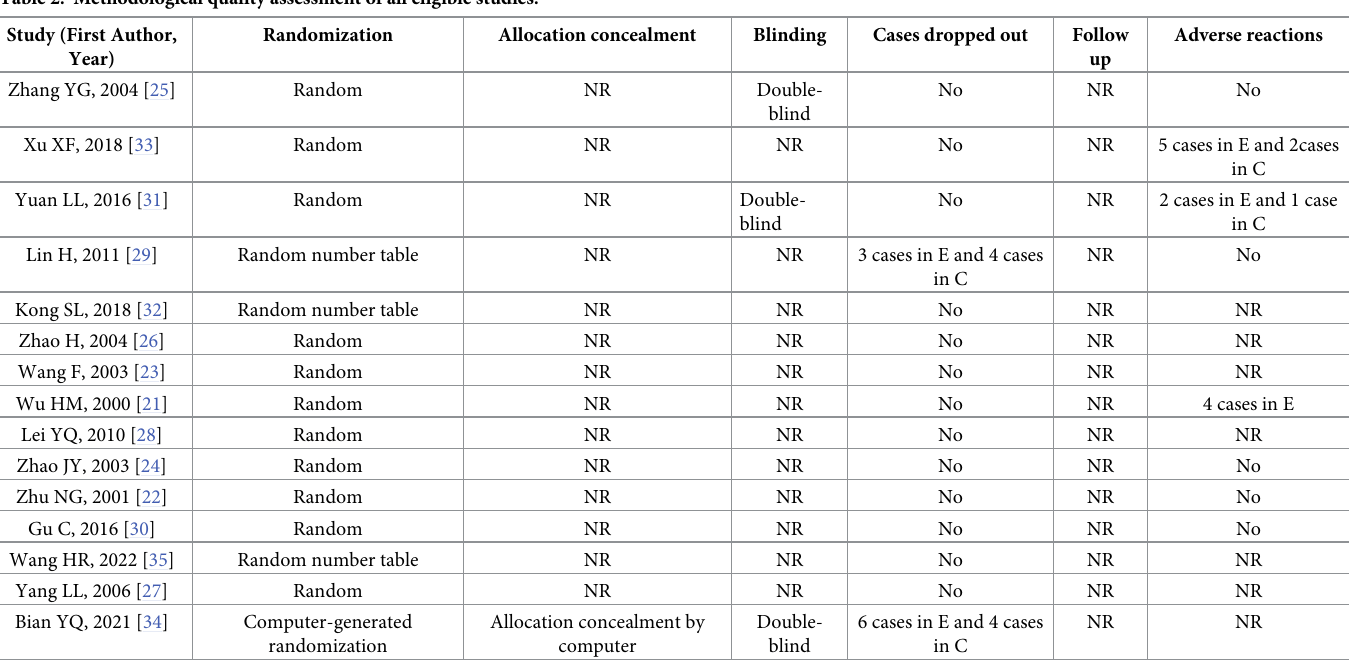
Table 2. Methodological quality assessment of all eligible studies. Study (First Author,